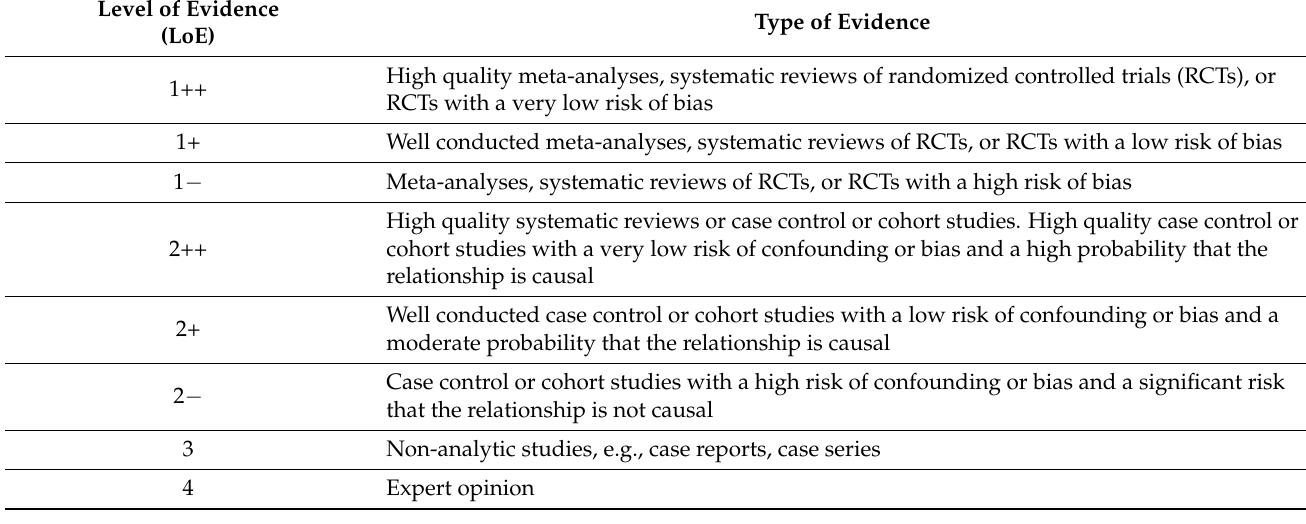
Table 2. Rating scheme for the strength of the evidence [11,16].